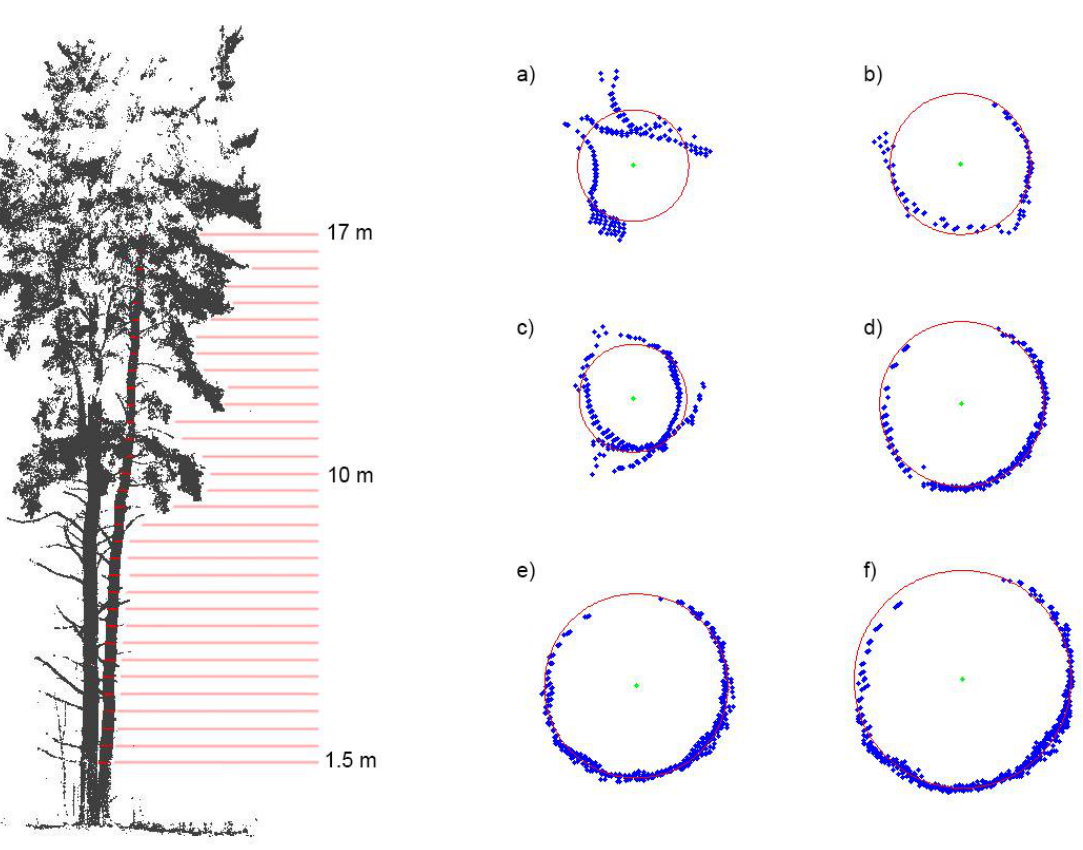
Figure 3. Left: The measured pine stem was segmented into 0.5 m increments. The segments are shown in red. In a), c) and e) the two-dimensional circle is fitted to a segmented point cloud combined from three different low resolution scans (a multi- scan) under 9 m/s wind at 2, 8 and 14 m heights from orthographic top projection. Images b), d) and f) are the corresponding results for circle fittings under 3 m/s wind conditions. Case a) shows a case where wind speed totally distort the multi-scan point